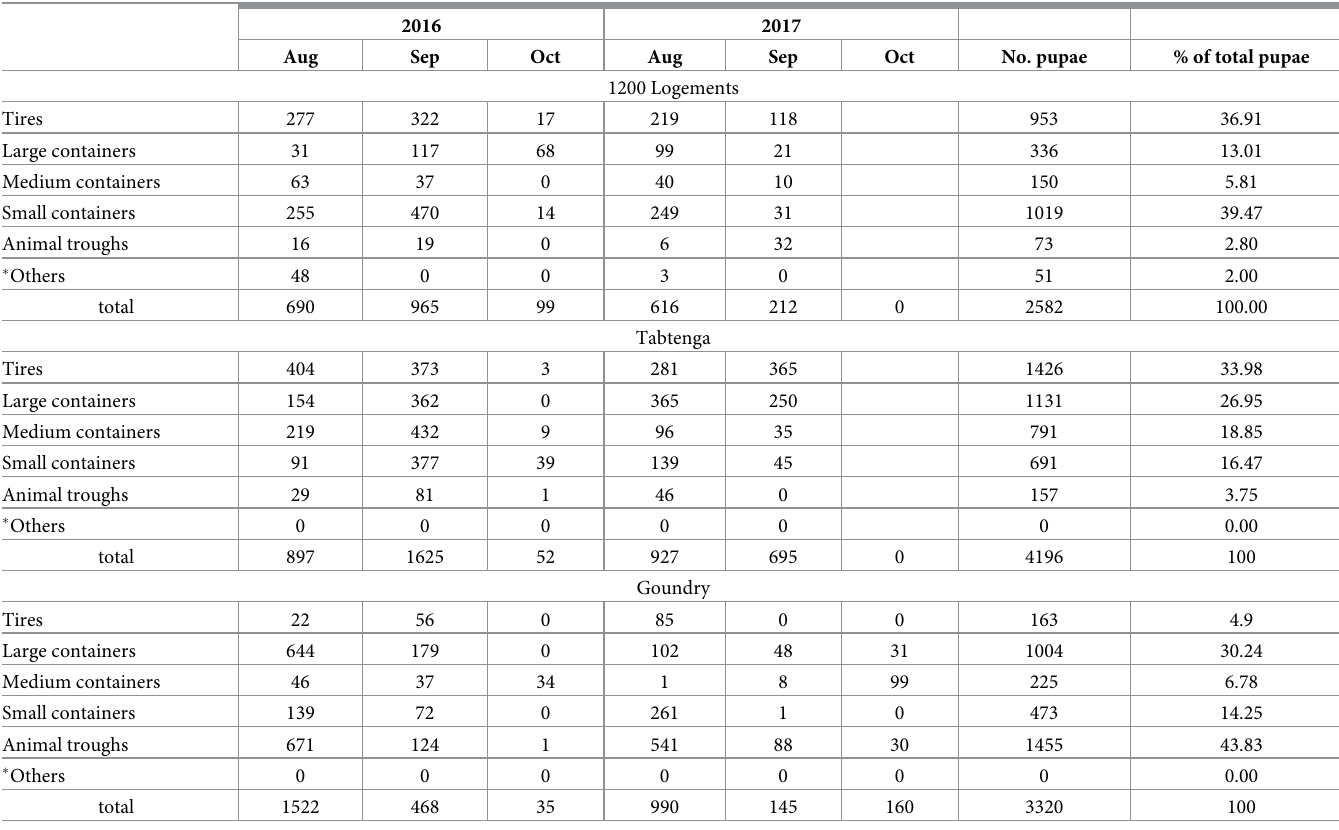
Table 4. Numbers of Aedes aegypti pupae found infesting containers and other potential habitats by locality, year of sampling and habitat